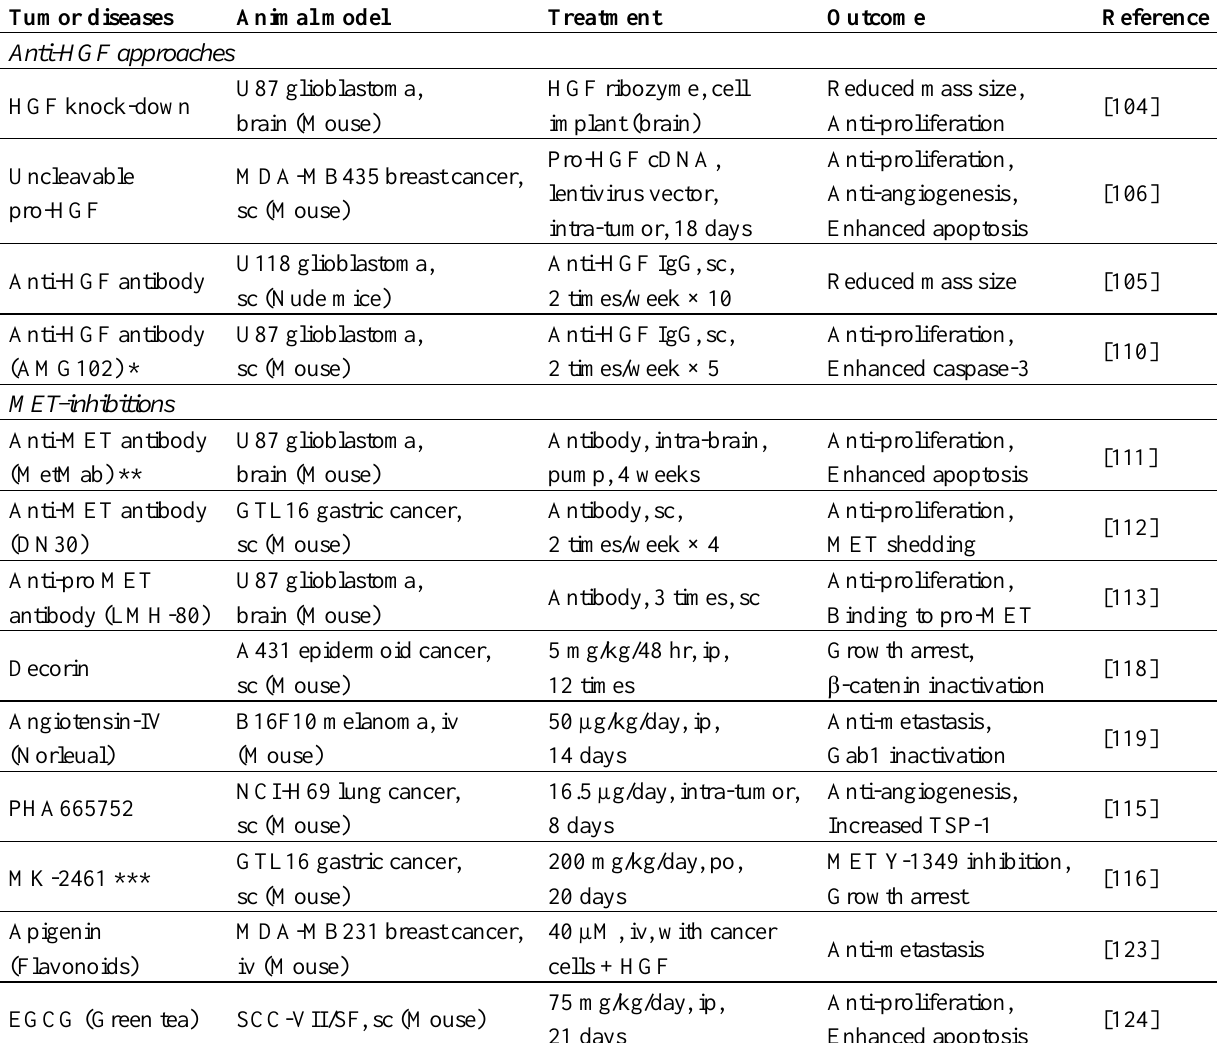
Table 3. Therapeutic effects of other HGF-antagonists or MET-inhibitors on experimental tumors in